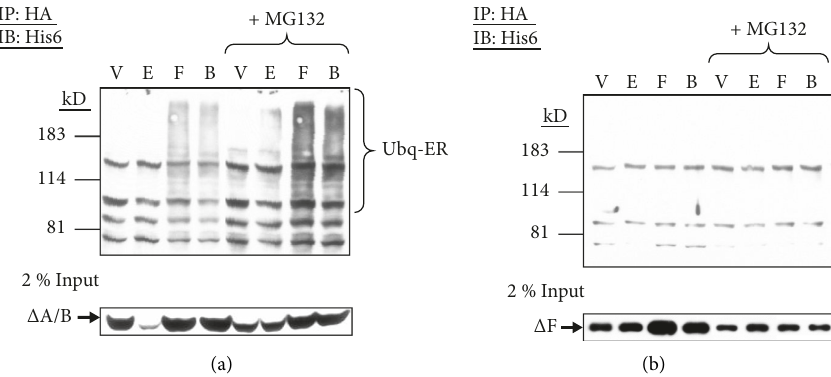
Figure 7: The F region is required for forskolin-stimulated ER α ubiquitination. (a) GH3 cells were transfected with His6-tagged ubiquitin and HA-tagged ER α Δ A/B expression vectors (2 μ g each). Cells were pretreated with MG132 (40 μ M) for 1h followed by vehicle (V), estradiol (E, 10nM), forskolin (F, 1 μ M), or both (B) for 6h. Cell lysates were subjected to immunoprecipitation (IP) with HA and analyzed by immunoblotting (IB) with the His6 antibody to detect ubiquitinated ER α Δ A/B (Ubq-ER). In parallel, the same lysates (10 μ l each) were also immunoblotted (IB) with the HA antibody (lower panel). (b) GH3 cells transfected with His6-tagged ubiquitin and HA-tagged deleted ER α ( Δ F) expression vectors (2 μ g each) were similarly pretreated with MG132, followed by vehicle (V), estradiol (E), forskolin (F), or both (B) for 6h. Cell lysates were similarly immunoprecipitated (IP) for HA and then immunoblotted (IB) for His6 to detect ubiquitinated ER α Δ F (upper panel) as well as immunoblotted (IB) with HA antibody for ER α Δ F in parallel (lower